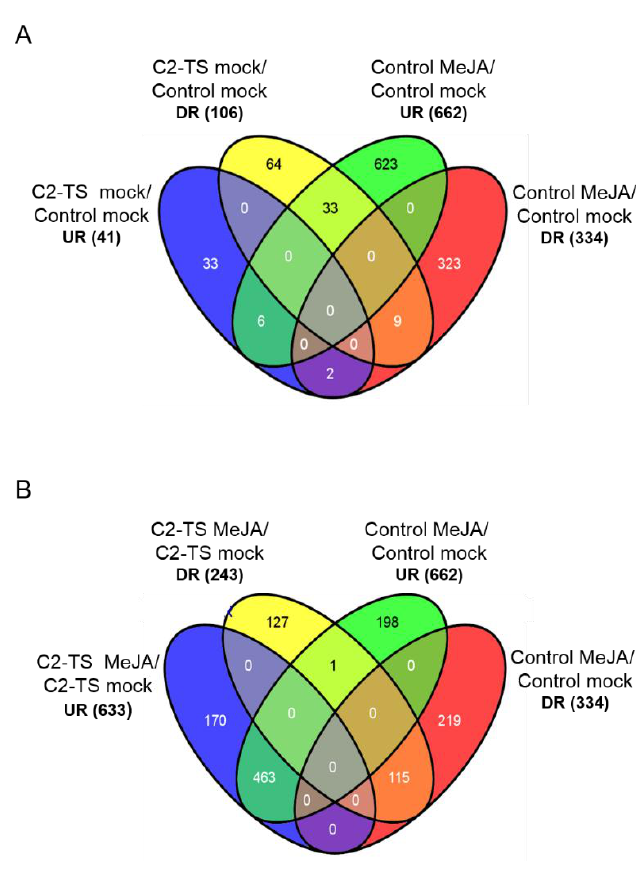
Figure 2. Venn diagrams showing the number of genes up- or down-regulated (UR or DR, respectively) in C2-TS plants, either JA- or mock-treated (in ( A , B ), respectively), and JA-treated control plants. The Venn diagrams were constructed using the software Venny (http://bioinfogp.cnb.csic.es/tools/venny). Total number of genes in each subset is indicated in brackets.